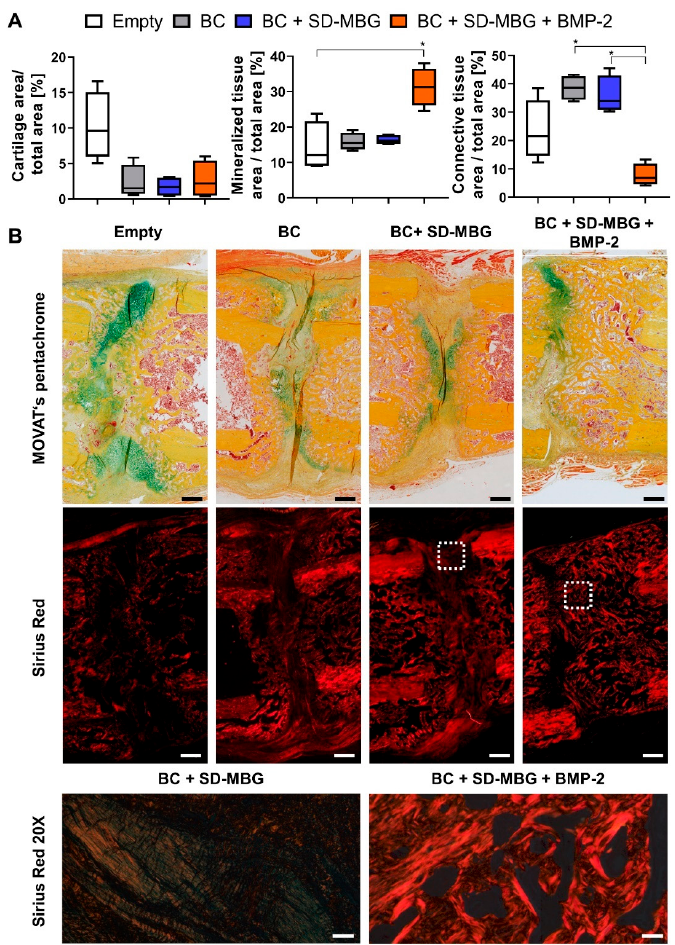
Figure 6. Histological and histomorphometrical analysis of rat femora at four weeks post-osteotomy of the osteotomy gap area via MOVAT’s pentachrome and sirius red staining. ( A ) Histomorphometry evaluation of the tissues present in the osteotomy gap based on the MOVAT’s pentachrome. The cartilage, mineralized and connective tissue fraction are depicted normalized to the callus area. Shown are Tukey box plot distributions with line at median. A Kruskal-Wallis test with Dunn’s multiple comparison test was performed using the BMP-2 group as comparator. ( B ) Representative images of the gap area for all groups. Top panel: MOVAT’s pentachrome (yellow/orange: mineralized tissue, green/blue: cartilaginous tissue, orange/red: muscle tissue), 10× magnification. Middle and bottom panel: sirius red staining, imaged using polarized light. Middle panel: 10× magnification. Bottom panel: 20× magnification, imaged at the periosteal side in between the cortical bone fracture ends. Red stained fibers represent collagen type 1, greenish fibers represent collagen type 3. Scale bars for 10 × = 500 µ m, 20 × = 50 µ m. p -values for statistical significance were * p <